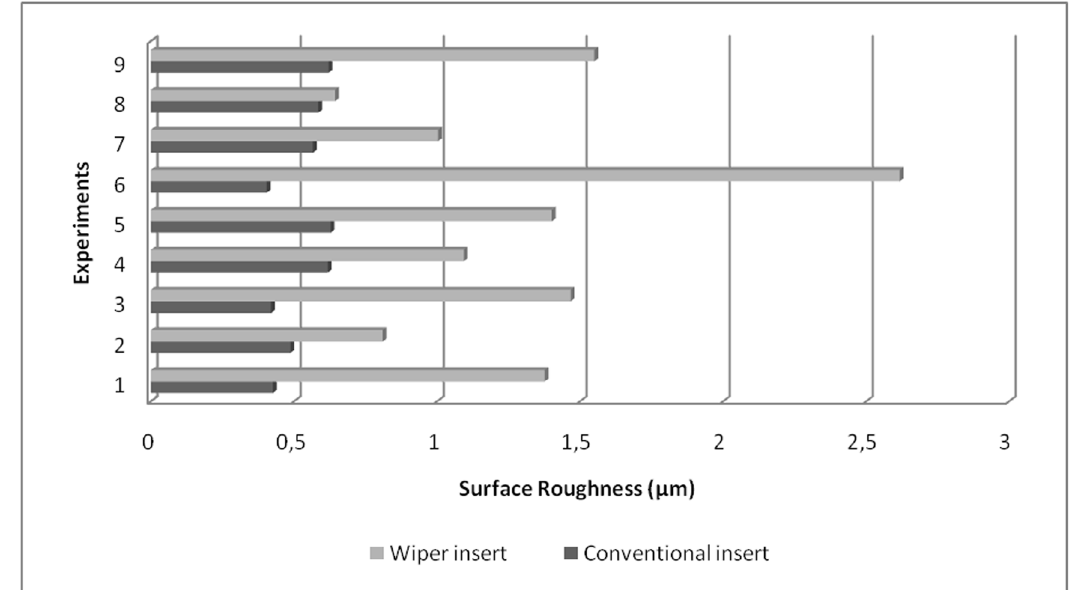
Figure 2: Surface roughness